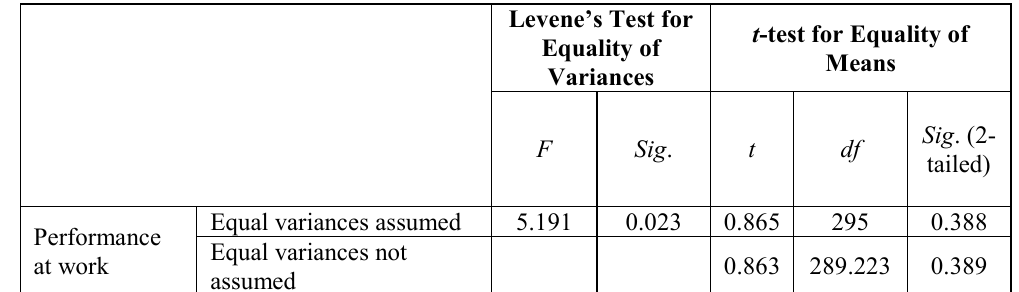
Table 3. Independent Variable Test for Performance at Work by